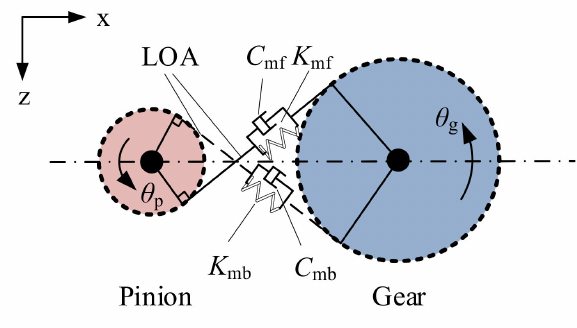
Figure 3. Schematic diagram of gear mesh.